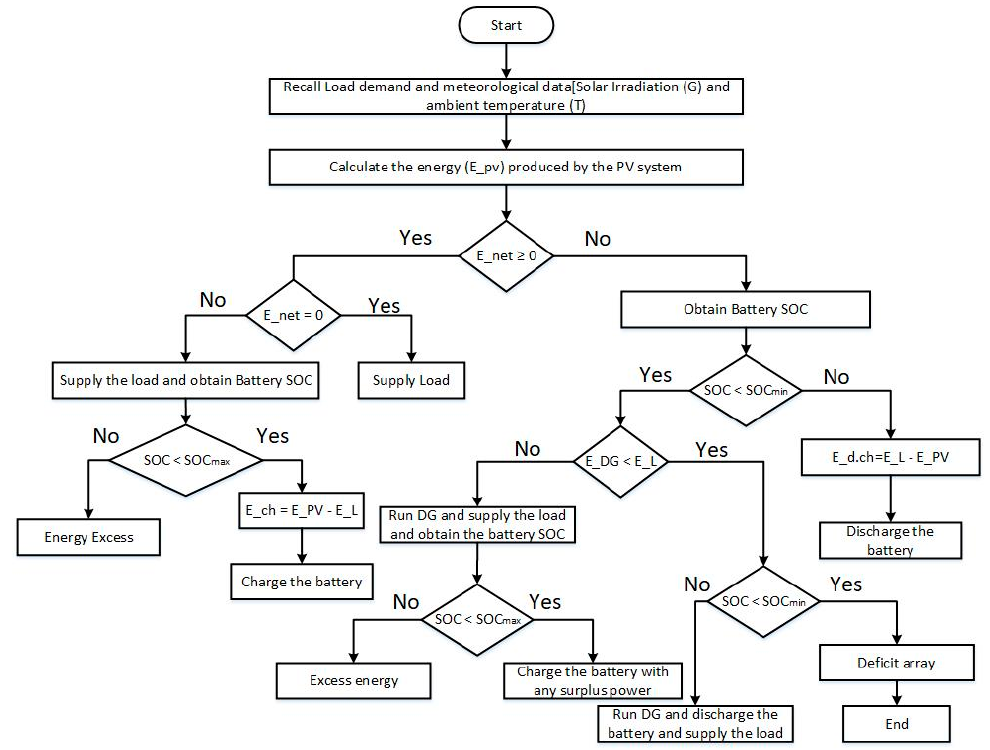
Figure 6. Cycle charge dispatch strategy .